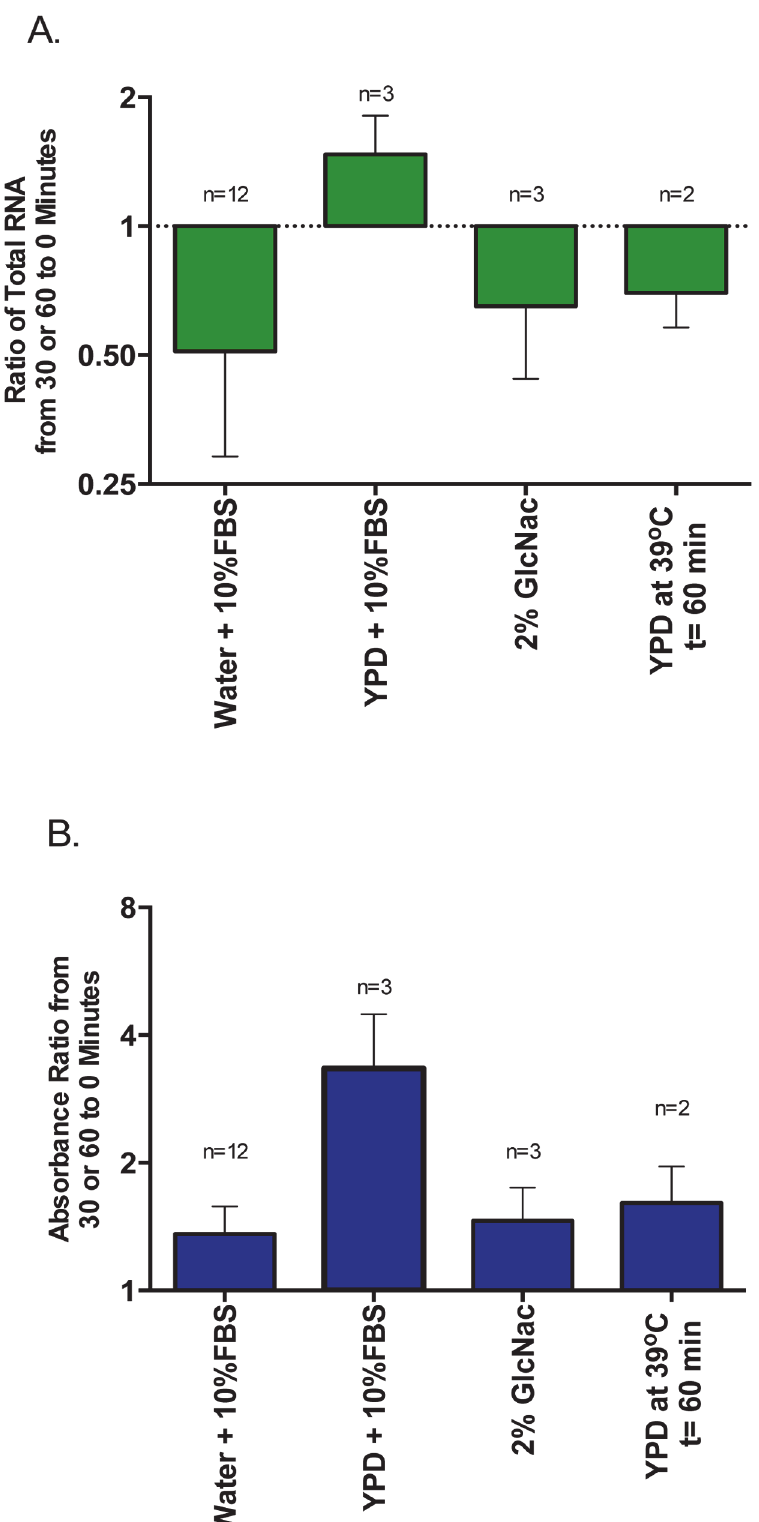
Fig 6. RNA content changes in C . albicans with various modes of hyphal stimulation. A. Bars represent ratios of total RNA content at end of hyphal stimulation to RNA content prior to stimulation. First bar shows